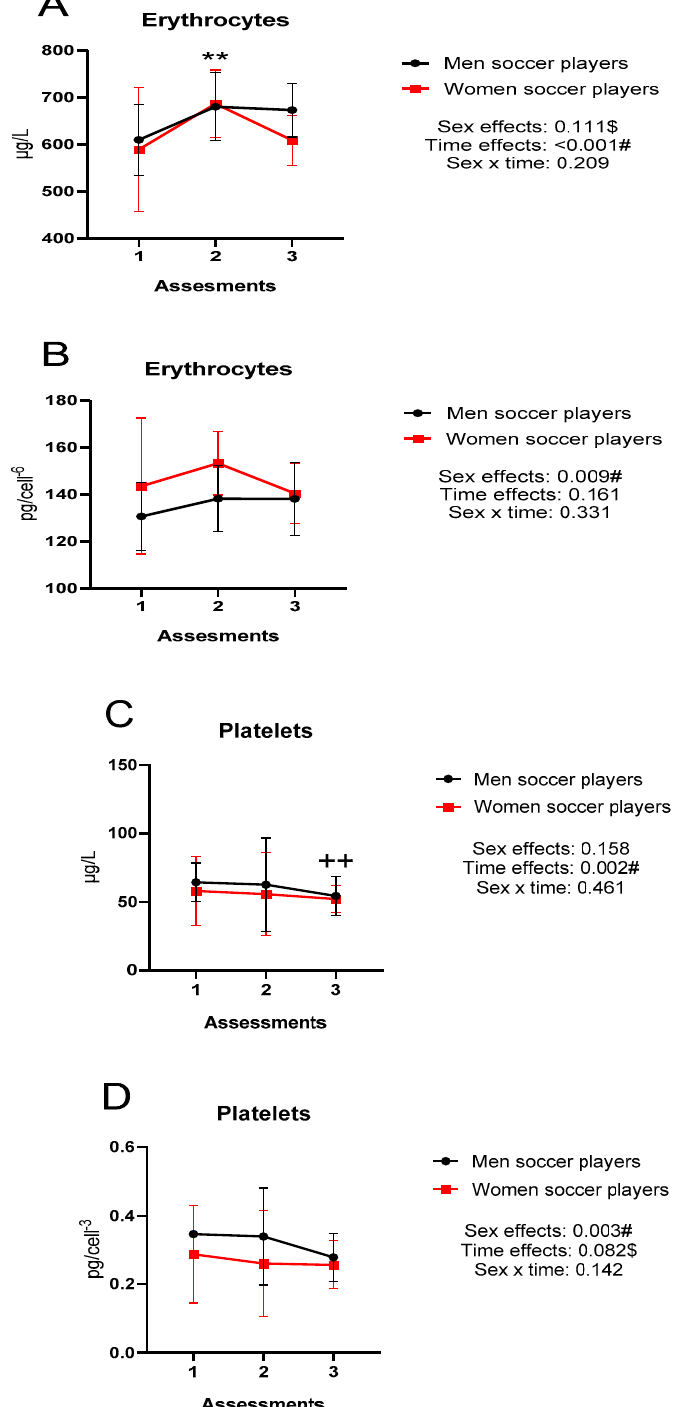
Figure 2. ( A ) absolute Cu concentrations in erythrocytes; ( B ) Cu concentrations in relation to the number of erythrocytes; ( C ) absolute Cu concentrations in platelets; ( D ) Cu concentrations in relation to the number of platelets; # large effect size (>0.14); $ moderate effect size (0.06–0.14); ** p < 0.01 differences between the 1st and 2nd assessment; ++ p < 0.01 differences between the 1st and 3rd assessment; Cu: copper.